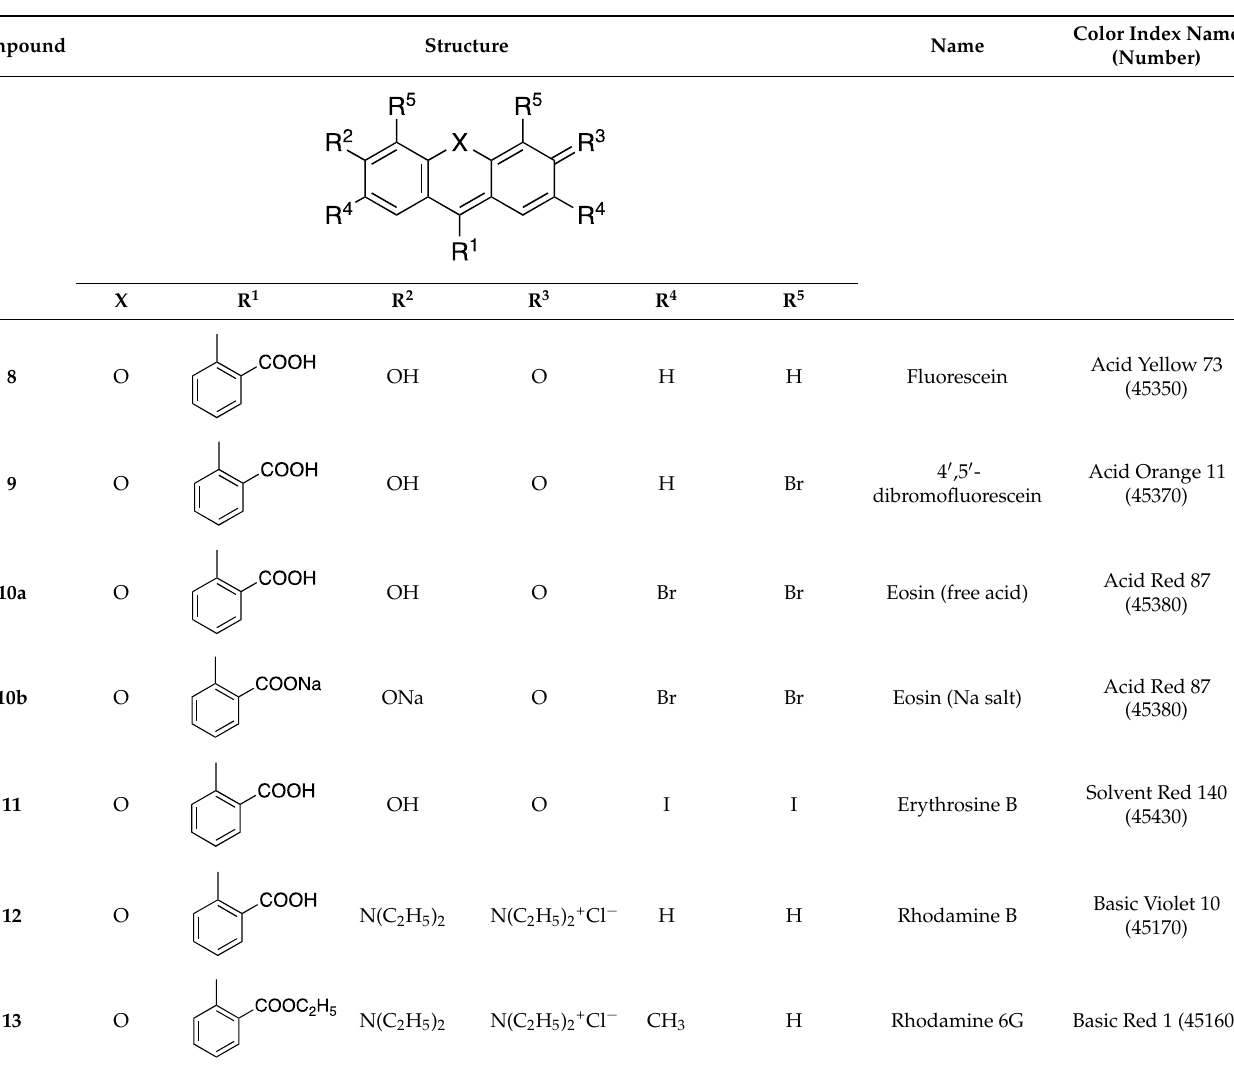
Table 2. Arylmethane heterocyclic (acridine and xanthene) dyes. Table 2. Cont.